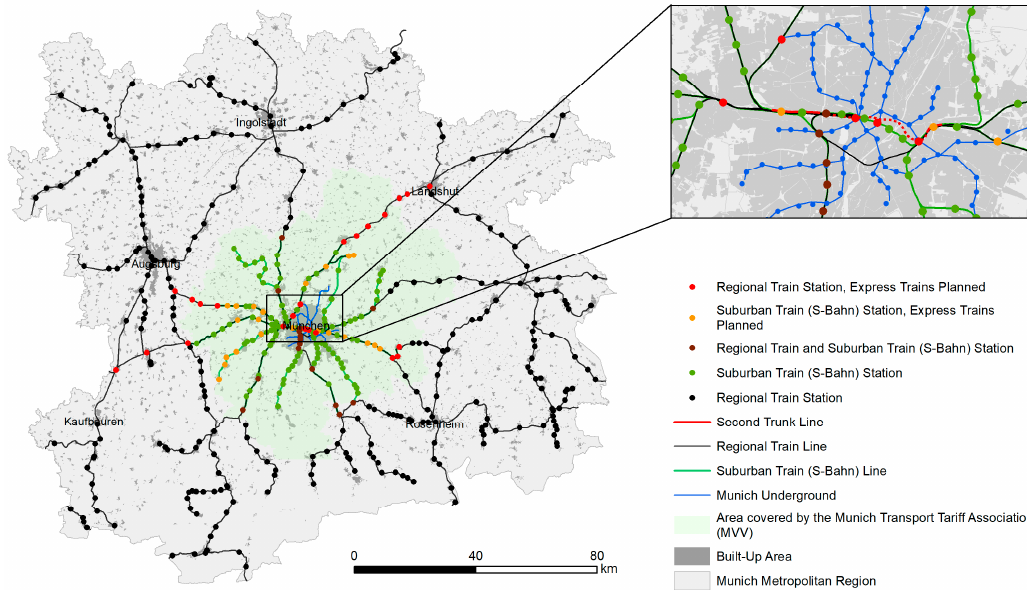
Figure 1. Current and future rail infrastructure in the Munich Metropolitan Region (Source: own work, using geodata by Bayerische Vermessungsverwaltung, Bundesamt für Kartographie und Geodäsie, Deutsche Bahn).